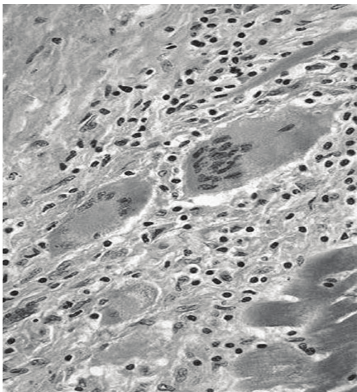
Figure 5: Histopathology demonstrating multinucleated giant cells and numerous lymphocytes infiltrating the